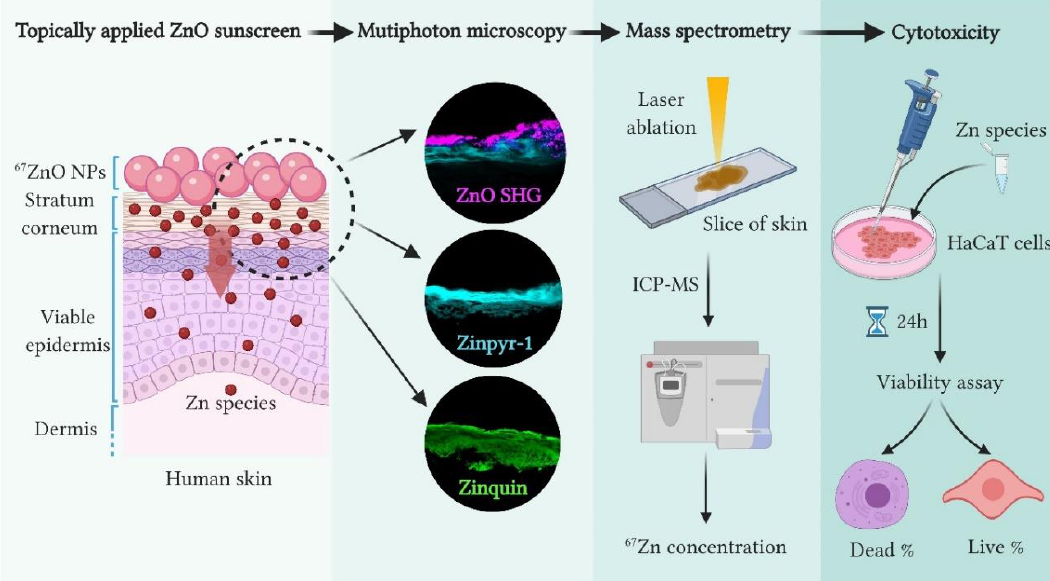
Figure 1. Schematic illustration of techniques used in this study to image and quantify the permeated zinc species formed by 67 ZnO dissolution on the skin surface. Zinc species were detected by multiphoton microscopy using the second harmonic generation signal of ZnO nanocrystals, by multiphoton and confocal fluorescence microscopies using fluorescent zinc sensors, Zinquin ethyl ester and Zinpyr-1; and mass spectrometry. Created with BioRender.com.